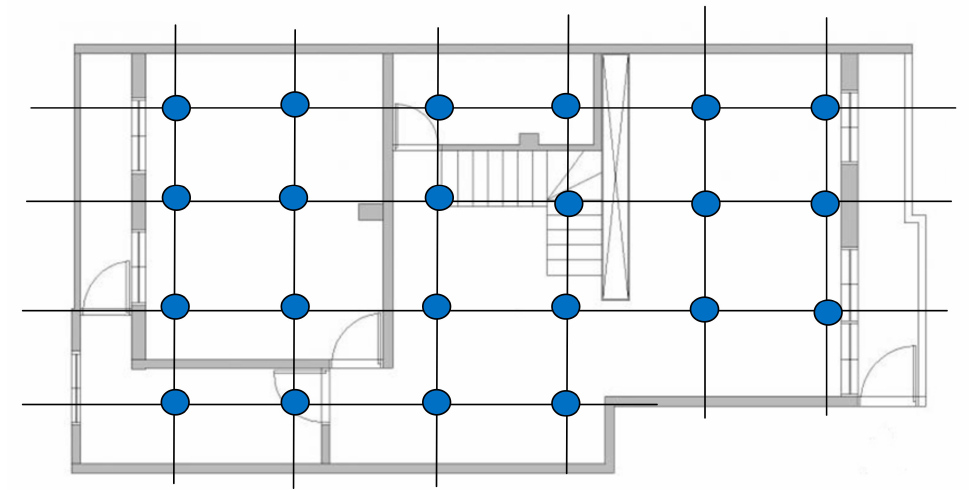
Figure 6. Divide the room into grids to create a magnetic field database.